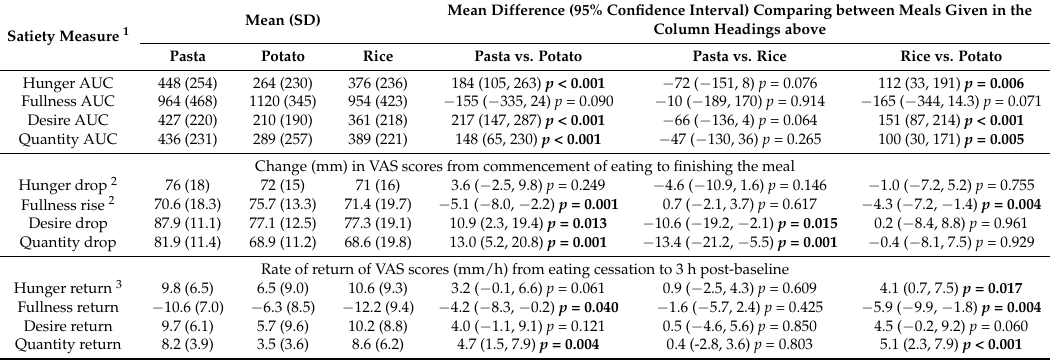
1 AUC Area-Under-the-Curve (cm · min); 2 drop/rise = change in score (mm) from baseline to immediately after finishing the meal; 3 return from a satiated to a less satiated condition over time (mm/h). A positive difference